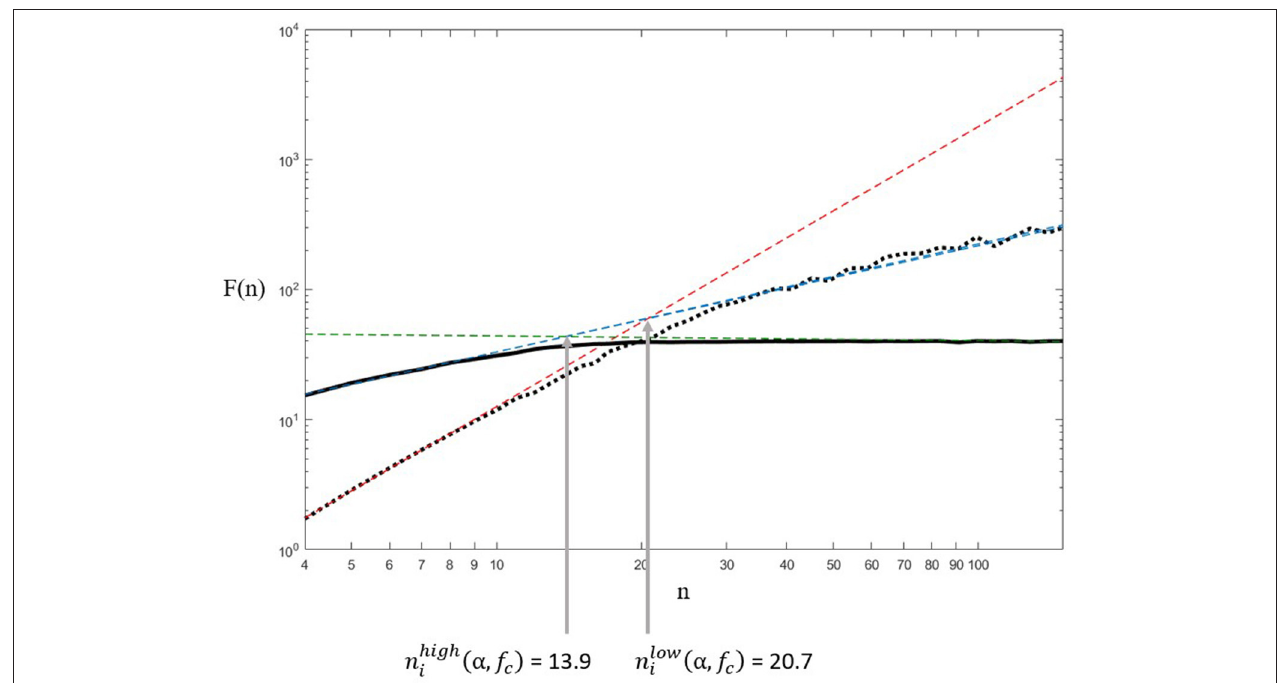
FIGURE 3 | Example of the estimation of the cutoff box of n low i (α , f c ) and n high i (α , f c ) , done in the low-passed signal X low i (α , f c ) (thick black dotted line), and high passed signal X high i (α , f c ) (thick black full line). In this example, we chose X low i = 1 (α = 0.8, f c = 0.056 ) . The crossover was considered to be at the intersection of the asymptotes in each signal (thin dashed straight lines). Note that the asymptote of X low i (α , f c ) for high values of n and the asymptote of X high i (α , f c ) for low values of n (thin dashed blue straight lines) are perfectly superimposed since they correspond to the unaltered frequency ranges of the original signal X i ( α ) (not plotted here for clarity), which has a unique scaling, hence a unique slope.